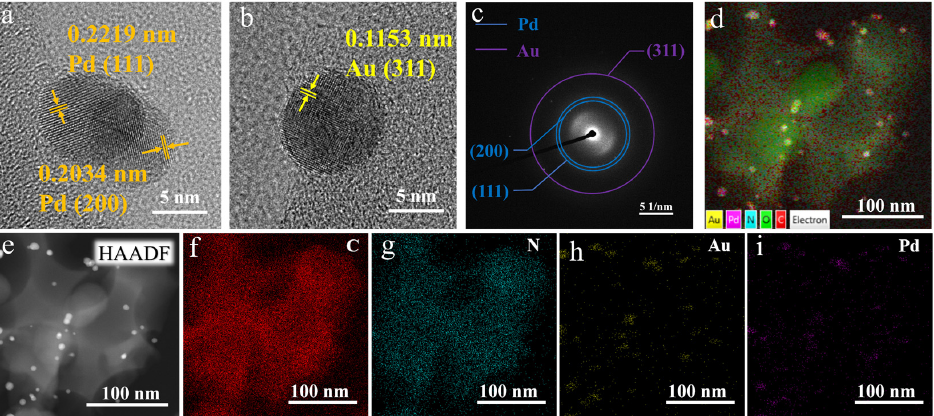
Figure 3. HR-TEM ( a , b ), SAED ( c ), EDS ( d ), HAADF ( e ) and element mapping images( f – i ) of the representative Au 1 Pd 1 /N-BN 2 C nanocatalysts.